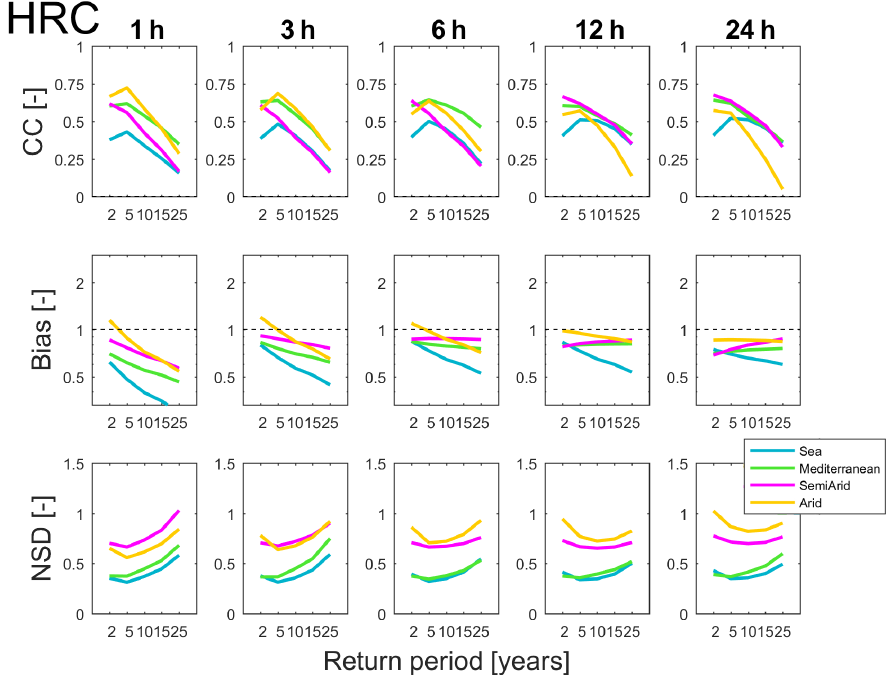
Figure 7. Comparison of IDF values between HRC and radar for different climatic regions. Blue lines represent sea areas while green, pink, and orange lines represent the Mediterranean, semiarid, and arid climates respectively. The upper row of panels shows the CC for different durations, the middle row the bias, and the lower row the NSD.